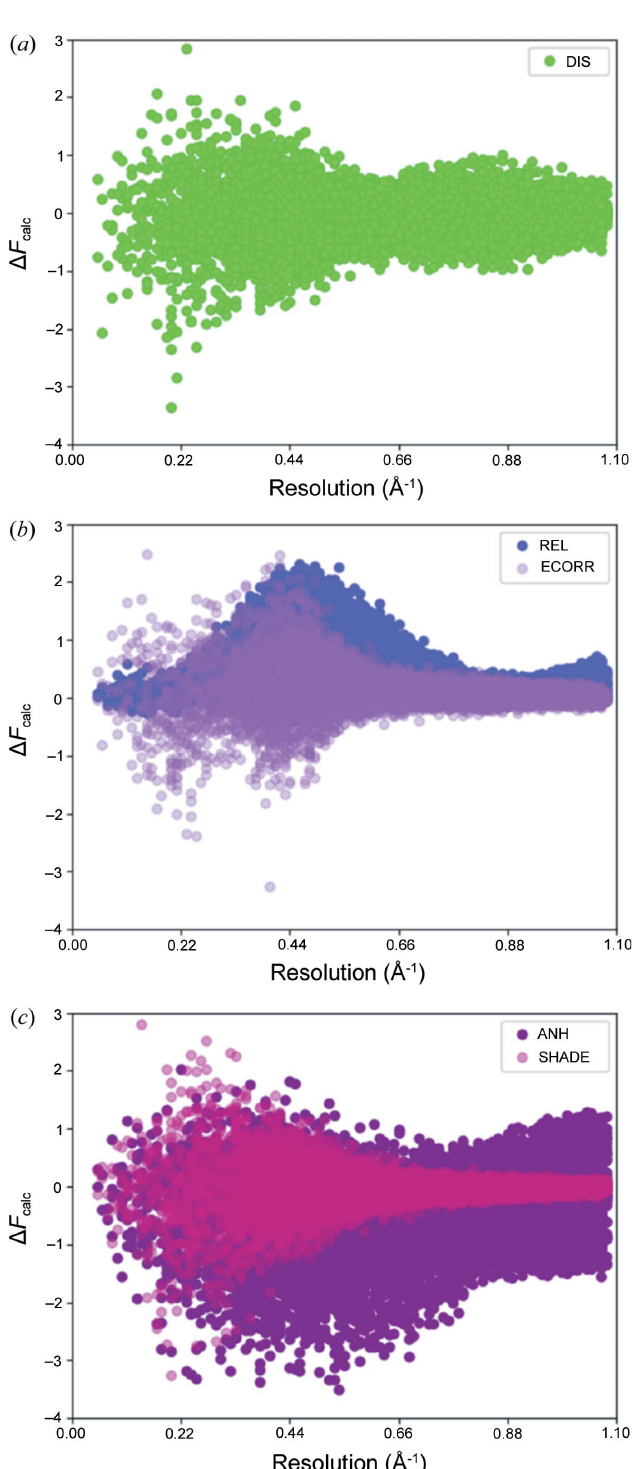
Figure 6 Differences in corresponding structure factors showing the effects of ( a ) disorder, ( b ) relativity and electron correlation, and ( c ) anharmonicity and SHADE. On the x axis is sin (cid:4) / (cid:2) (A˚ (cid:5) 1 ) up to the maximum experimental resolution. On the y axis is the difference of calculated structure factors in absolute scale ( (cid:2) F calc